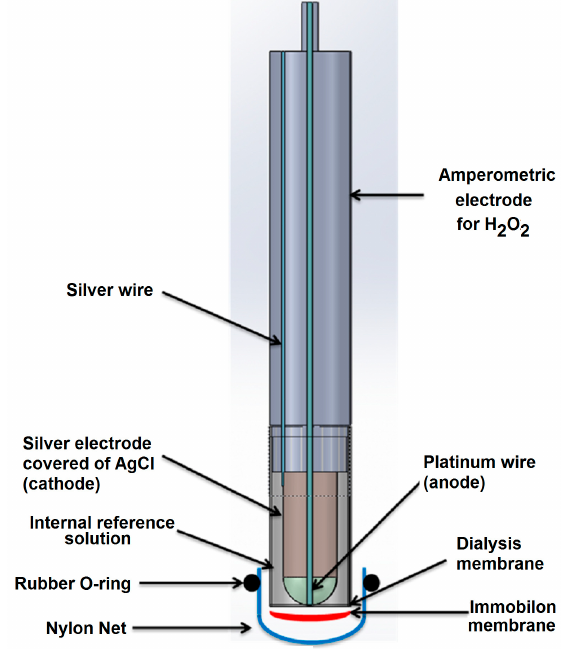
Figure 3. View of amperometric immunosensor for ampicillin determination using an H 2 O 2 electrode as transducer and peroxidase as enzyme label.